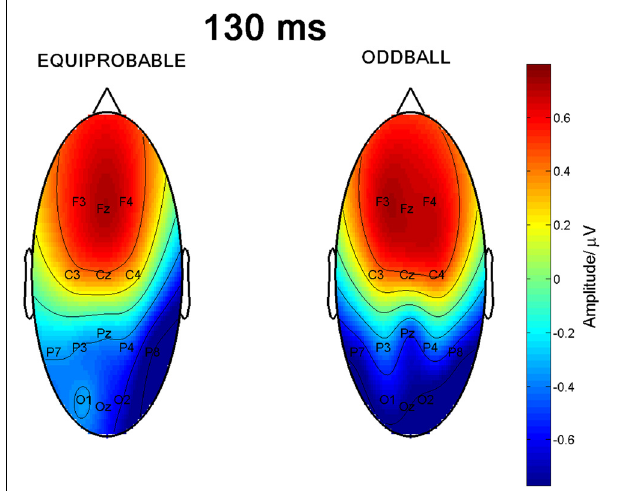
FIGURE 6 | Scalp potential maps of the 130-ms component back-projected to the electrodes. Map for the equiprobable condition group on left and map for the oddball condition group on right.